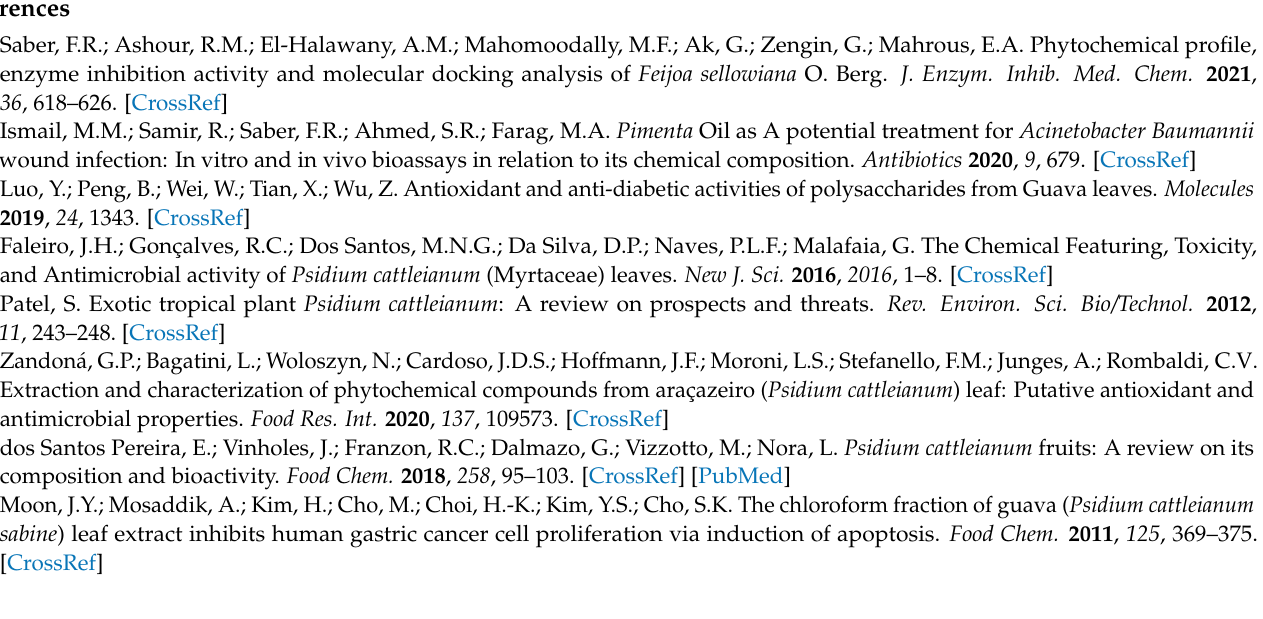
Supplementary Materials: Figure S1: EI-MS spectrum of compound 1 . Figure S2: 1 H-NMR spec- trum of compound 1 . Figure S3: 13 C-NMR spectrum of compound 1 . Figure S4: HMBC spectrum of compound 1 . Figure S5: Expanded HMBC spectrum of compound 1 , Figure S6: HSQC spectrum of compound 1 . Figure S7: expanded HSQC spectrum of compound 1 . Figure S8: HRMS (Neg- ative Mode) of compound 2. Figure S9: UV spectrum of compound 2 ( λ max = 294 and 341 nm), recorded in methanol. Figure S10: 1 H-NMR spectrum of compound 2 . Figure S11: 13 C-NMR spectrum of compound 2 . Figure S12: HMBC spectrum of compound 2 . Figure S13: Expanded HMBC spectrum of compound 2 . Figure S14: HSQC spectrum of compound 2 . Figure S15: Expanded HSQC spectrum of compound 2 , Figure S16: H-H COSY spectrum of compound 2 , Figure S17: Expanded aliphatic region of H-H COSY spectrum of compound 2